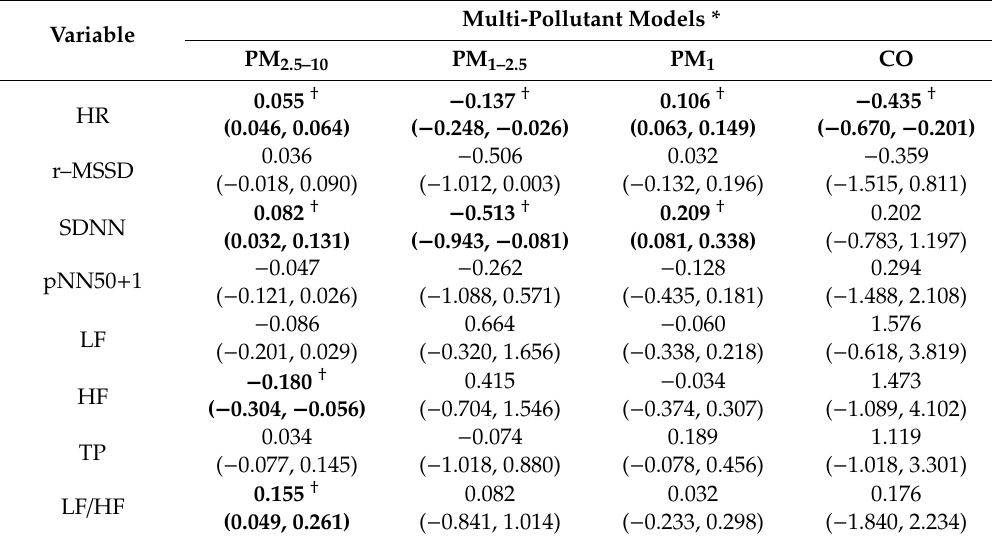
Table 2. Impacts of personal particulate matter (PM) and carbon monoxide (CO) exposures on HRV indices in multi-pollutant